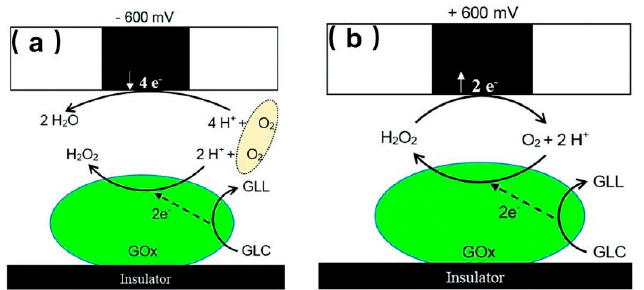
Figure 7. ( a ) Schematics of processes occurring during SECM measurements on both glucose oxidase (GOx)-modified and ultramicroelectrode (UME) surfaces in redox competition (RC)-SECM mode without any redox mediator; ( b ) Schematics of SECM processes occurring on GOx-modified and UME surfaces in generation and collection mode (GC) mode without any redox mediator. In the scheme, gluconolactone is abbreviated as GLL, and glucose is abbreviated as GLC. Copyright (2014) Royal Society of Chemistry.